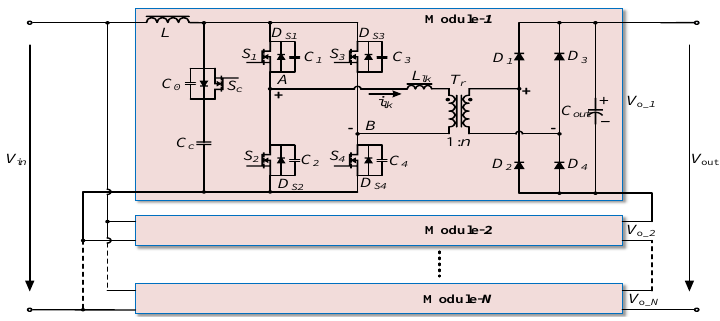
Figure 3. BFBIC based IPOS cascaded DC/DC converter.